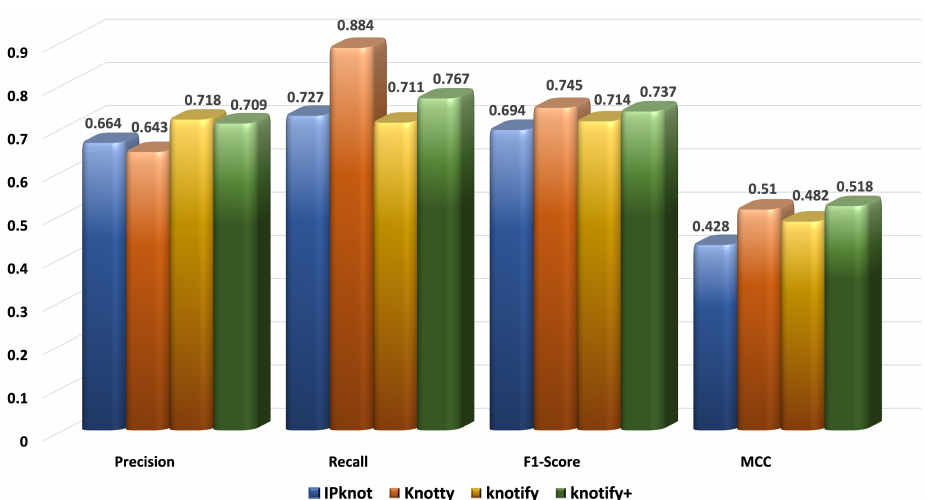
Figure 8. Metrics for the sequences of length ≥ 40 and <